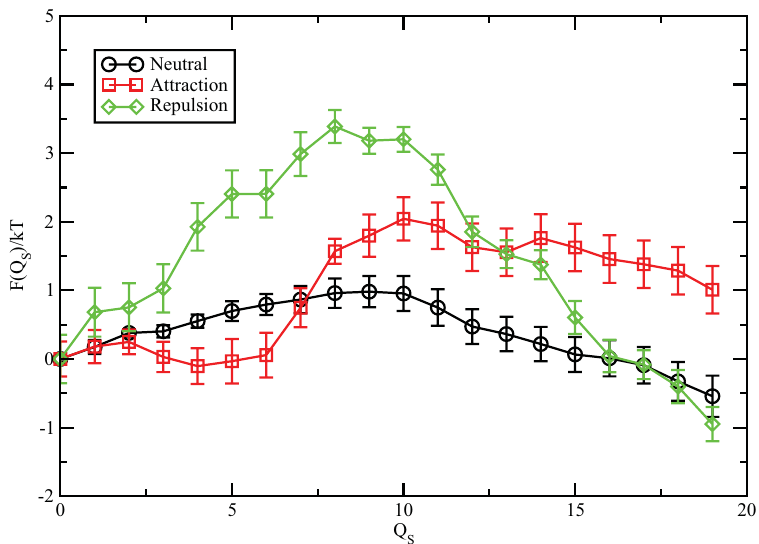
Figure 5. Translocation free energy as a function of the number of translocated amino acids Q s , for the different interaction scenarios. For steric interactions (circles), the profile is rather symmetrical and presents a small barrier of 2 kT . In the presence of mutual attraction between chains and the helix (squares), the barrier is very small and there is a symmetry breakingthat favours the binding of the helix to the chains inside the cavity (small values of Q s ). The final scenario is for repulsive helix-chains interactions (diamonds) where we have a symmetric barrier 4 kT high.